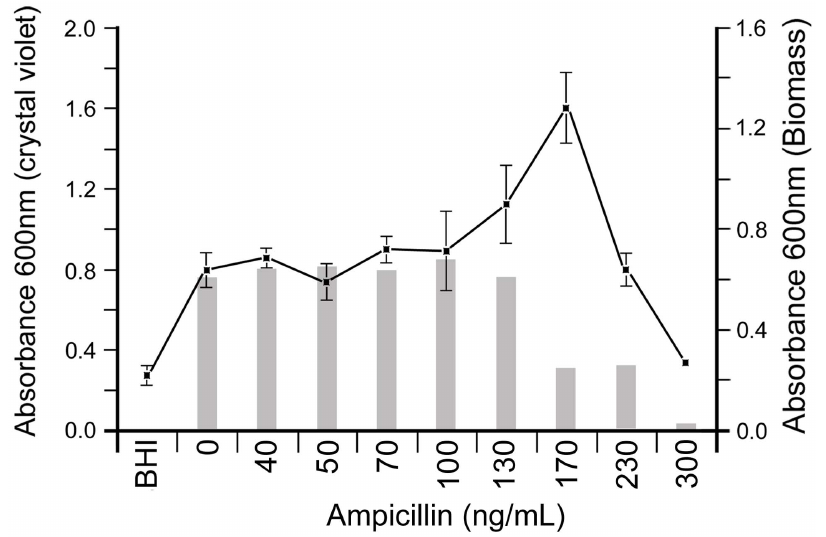
Figure 3. PittGG biofilm formation is stimulated by ampicillin in a narrow concentration range. Crystal violet assay of 1-day PittGG biofilms, formed in the presence of increasing amounts of ampicillin up 300 ng/mL, showed a stimulation of biofilm formation at 170 ng/mL concentration.